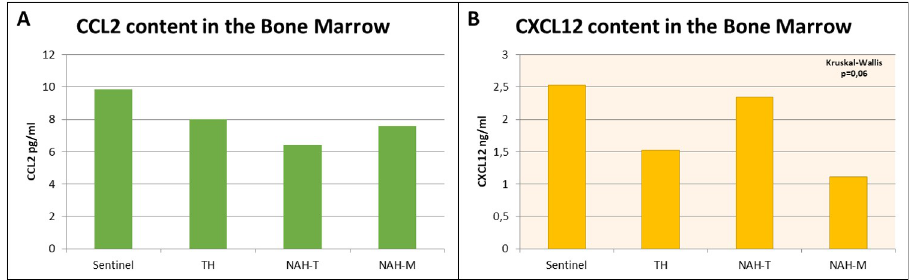
Fig 4. Cytokines content in the bone marrow. A) CCL2 content: no significant difference was found among groups. B) R&L stress did not cause massive neuroinflammatory activation, despite a trend of CXCL12 decrease in TH and NAH-M groups with respect to Sentinels (Kruskal-Wallis test: p = 0,06), which might indicate an inflammatory process at its final stage.